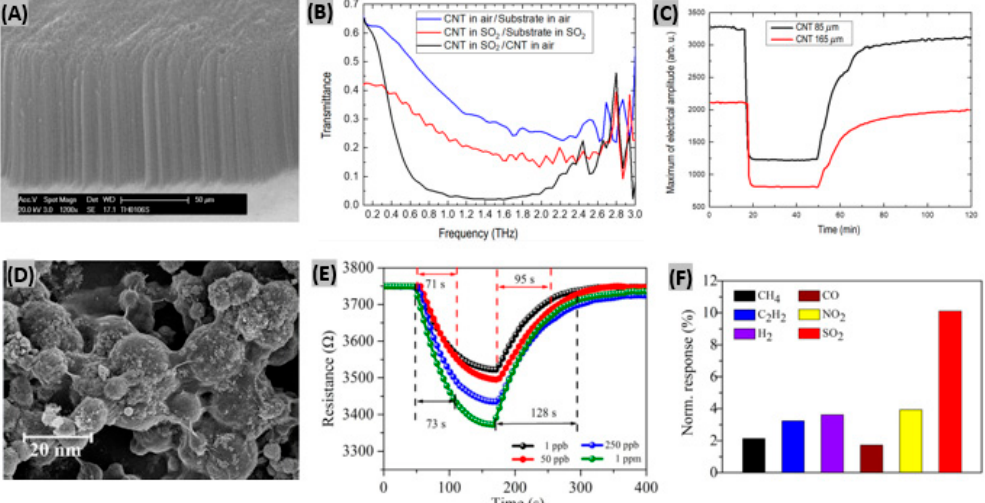
Figure 7. ( A ) SEM image of a VACNT layer on Si/SiO 2 substrate. ( B ) Normalized transmittance spectra of Si/SiO 2 /VACNT in air and SO 2 . ( C ) Maximum of electrical amplitude vs. time response in transmission measurements with 85 um and 165 um thick layers of VACNT. Figures adapted with permission from [114], Copyright 2018 Lietuvos mokslu˛ akademija. ( D ) SEM image of self-assembled TiO 2 /rGO film. ( E ) Response/recovery curves of TiO 2 /rGO sensor exposed to four different concentrations of SO 2 gas. ( F ) Normalized response of TiO 2 /rGO sensor toward 1 ppm of various gases at room temperature. Figures adapted with permission from [116], Copyright 2017